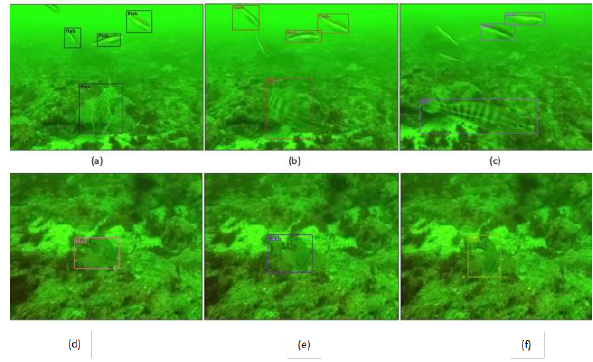
Figure 10 . Detection results for video frames: (a) Frame 532, (b) Frame 542, (c) Frame 563, (d) Frame 639, (e) Frame 650, and (f) Frame 657.